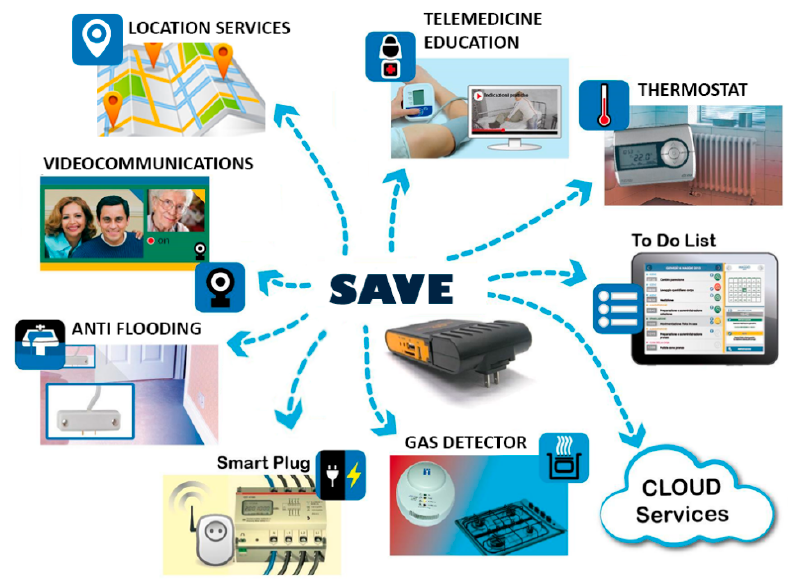
Figure 1. The original concept of the SAVE architecture based on multiple smart-home and wearable sensors streamed to a cloud-based platform.